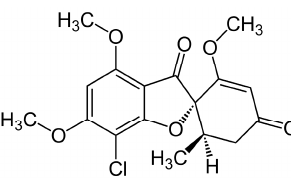
Figure 1. Chemical structure of griseofulvin.